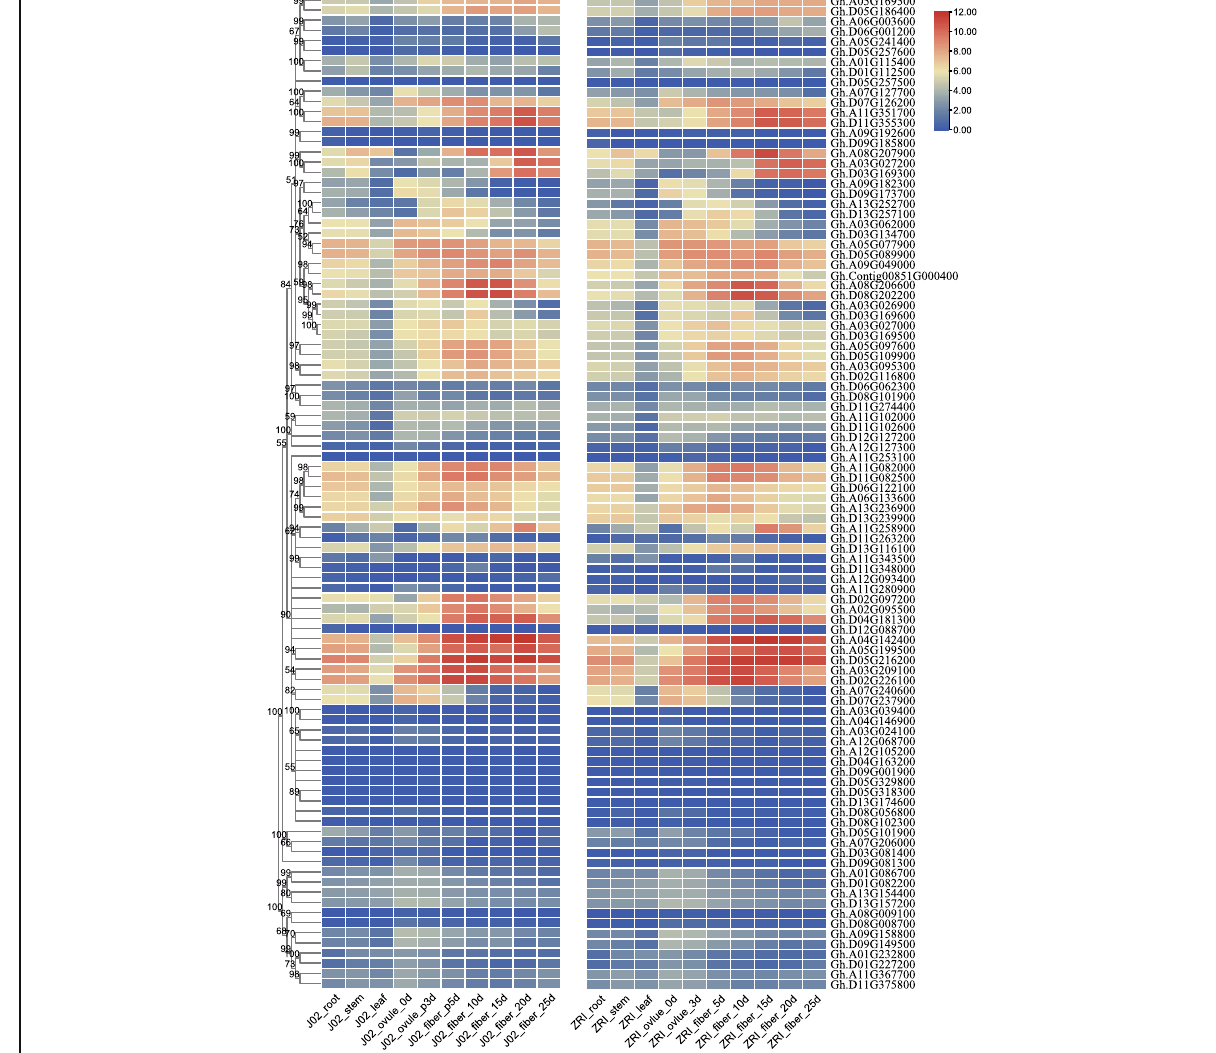
Fig. 5 Expression analysis of tubulin family genes in different tissues. A neighbor-joining phylogenetic tree was created using the MEGA7 program and expression level in different tissues of J02 – 505 and